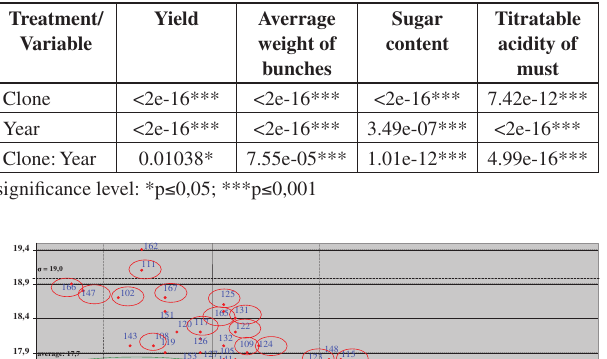
Table 3. The statistic analysis of individual and combined effects of variables on